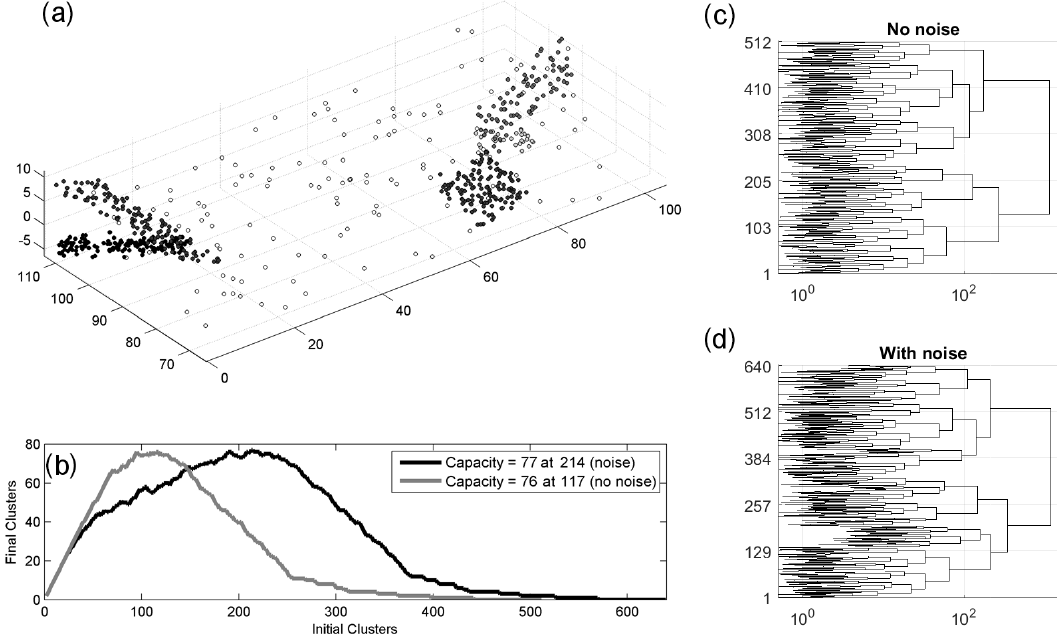
Figure 2. (a) Synthetic fault network with 640 points created by uniform sampling of five faults, each shown with a different shade according to its total number of points. Empty circles represent the 20% uniformly random background points. (b) Determination of the holding capacity (see main text) for the case with and without background points. (c–d) Dendrograms showing the agglomerative hierarchical cluster tree for the data with no noise (c) and with noise (d) . The horizontal length of each branch is the minimum distance D w (see Eq. 1) joining two